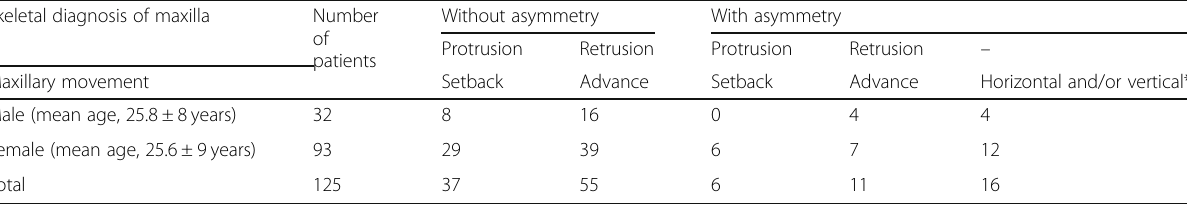
*Advance and setback are not done, only horizontal movement and/or vertical